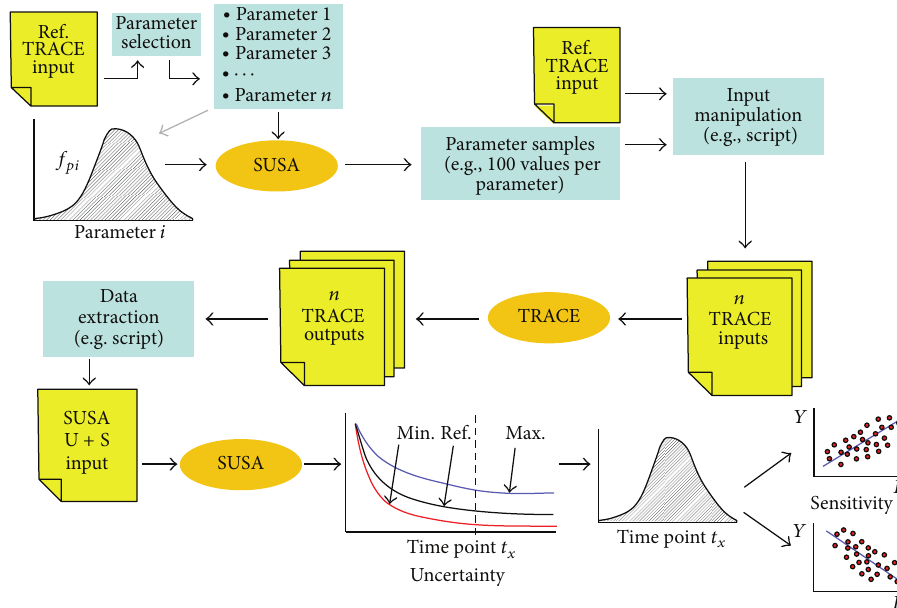
Figure 2: TRACE-SUSA information flow chart (with 𝑁 = 100 ).